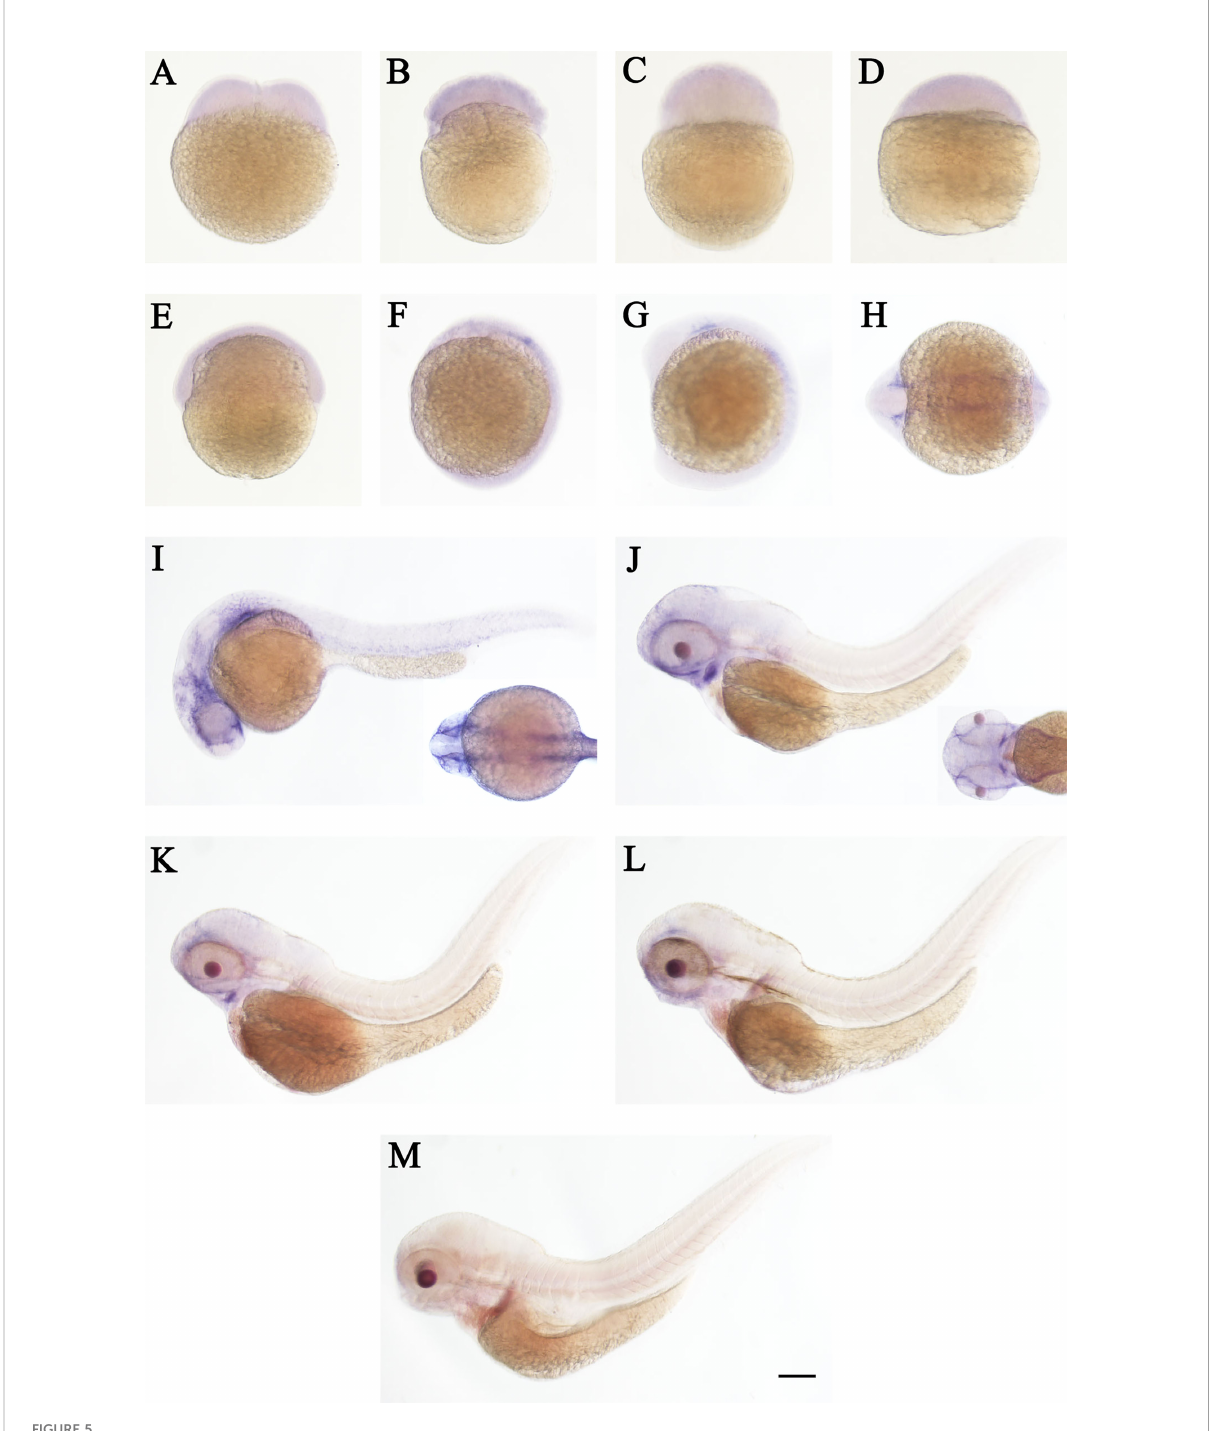
FIGURE 5 WISH of cd248b in zebra fi sh early embryos. Stages of embryonic development: (A) 2-cell; (B) 32-cell; (C) 512-cell; (D) sphere; (E) shield; (F) bud; (G, H) 10 somites; (I) 24 hpf; (J) 48 hpf; (K) 72hpf; (L) 96 hpf; (M) 120 hpf. hpf, hours post-fertilization. Scale bar, 100 m